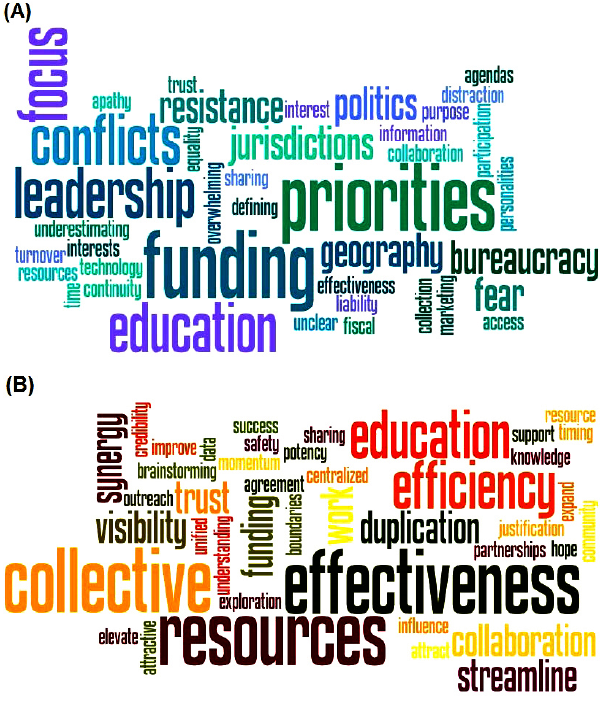
Fig. 2. Word diagrams of salient themes in the discussion about stewardship barriers (A) and opportunities (B) in the Exploring the Possibilities Workshop for the emerging cluster in Ely,